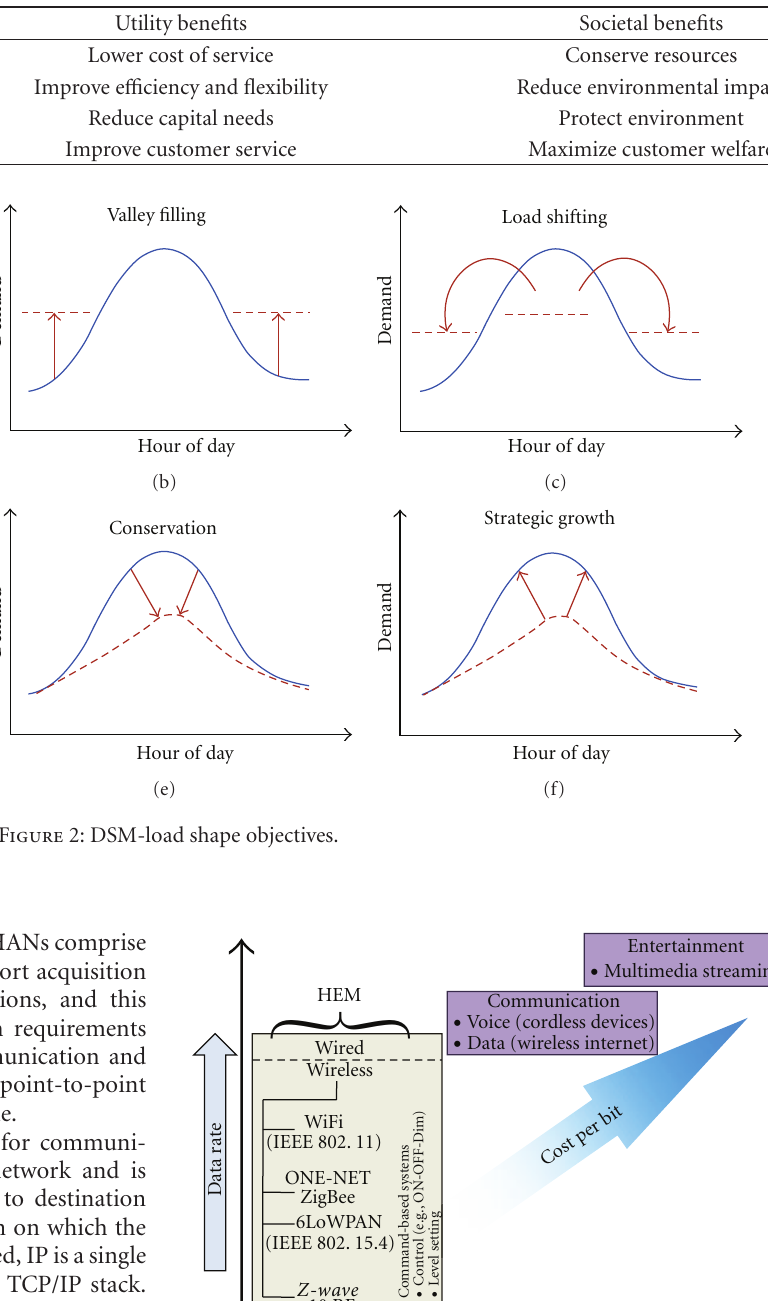
Table 1: DSM Benefits.